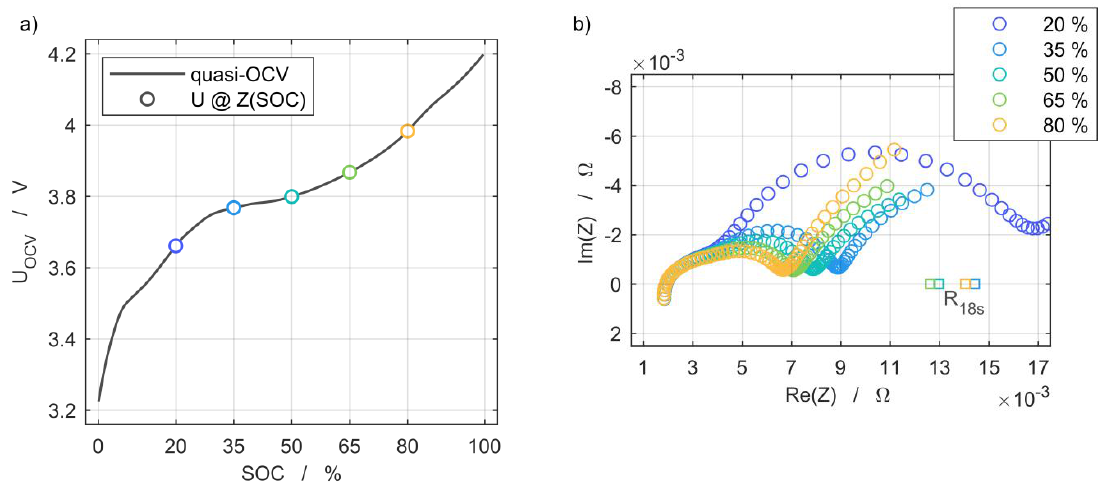
Figure 4. ( a ) Open-circuit voltage characteristic at 25 °C and indicated state of charge (SoC) levels of electrochemical impedance spectroscopy (EIS) and current pulse resistance measurement grid points, and ( b ) their dependency on the SoC at 25